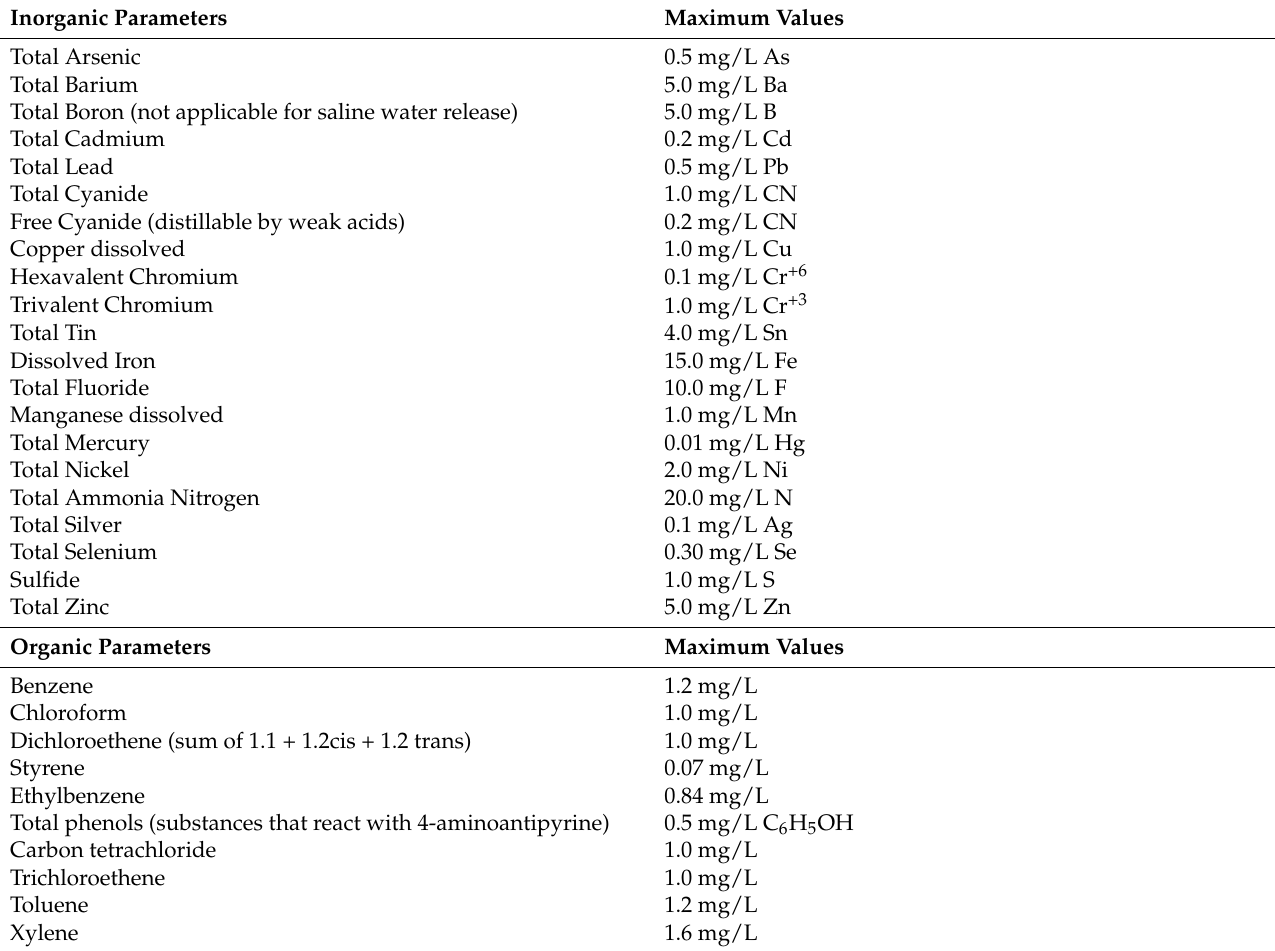
Table 1. Standard for effluent disposal in sewage